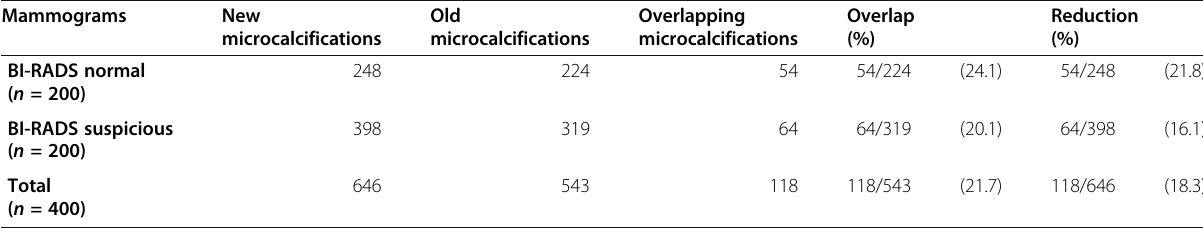
Table 2 Elimination of old microcalcifications that appear in both screening rounds, in BI-RADS normal and suspicious